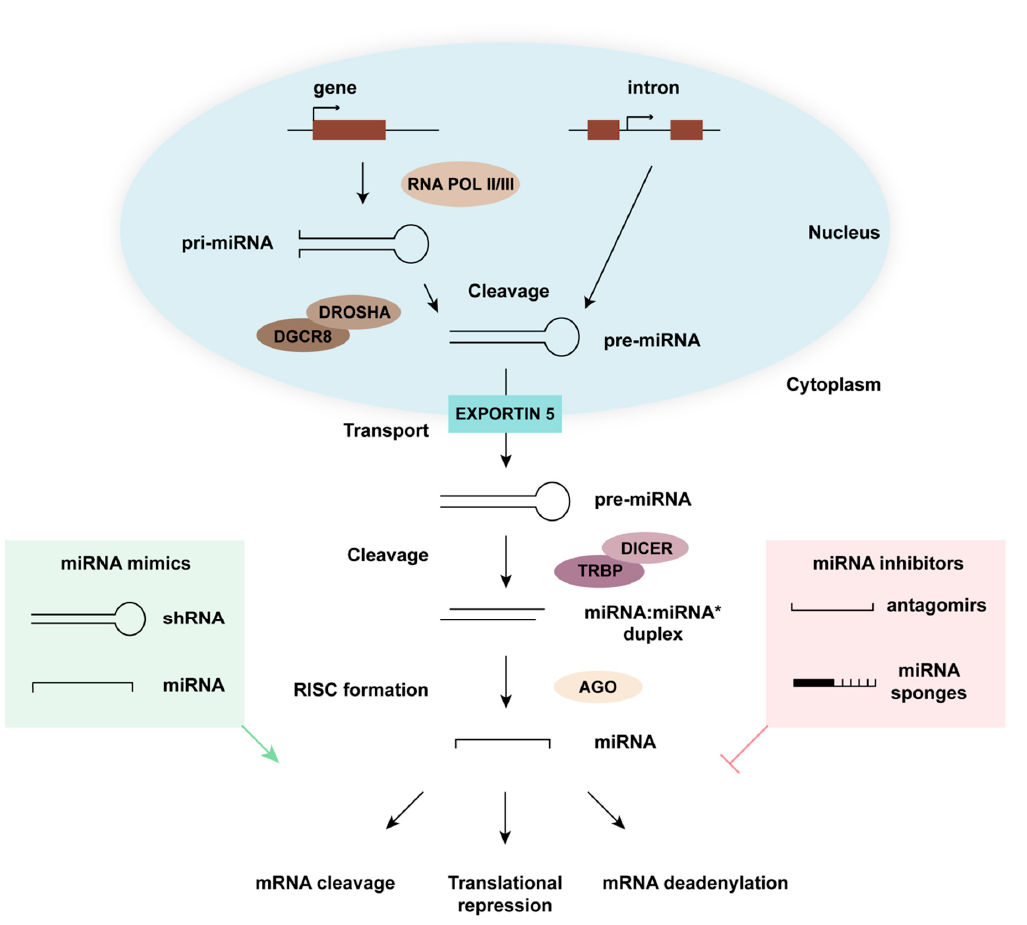
Figure 1. MicroRNA (miRNA) pathway. miRNA biogenesis starts in the nucleus where partially self-complementary RNA polymerase II or III transcripts from a miRNA gene or from an intronic region assemble into a hairpin-like structure known as primary (pri)-miRNA. Pri-miRNAs are cleaved by the DiGeorge Critical Region 8 (Dgcr8)/Drosha complex and transported to the cytoplasm via Exportin 5. In the cytoplasm, pre-miRNAs are cleaved by the Dicer/HIV-1 TAR RNA binding protein (TRBP) nuclease complex, thereby giving rise to a miRNA duplex. This duplex is then loaded onto the Argonaute (AGO) protein, a component of the RNA-induced silencing complex (RISC), where one of the two strands is discarded while the other serves to search complementary transcripts. Targets bound by miRNAs exhibit reduced translational efficiency, mainly as a consequence of mRNA cleavage or deadenylation. The miRNA pathway can be modulated by introducing miRNA mimics (green) or miRNA inhibitors (red). shRNA is small hairpin RNA.